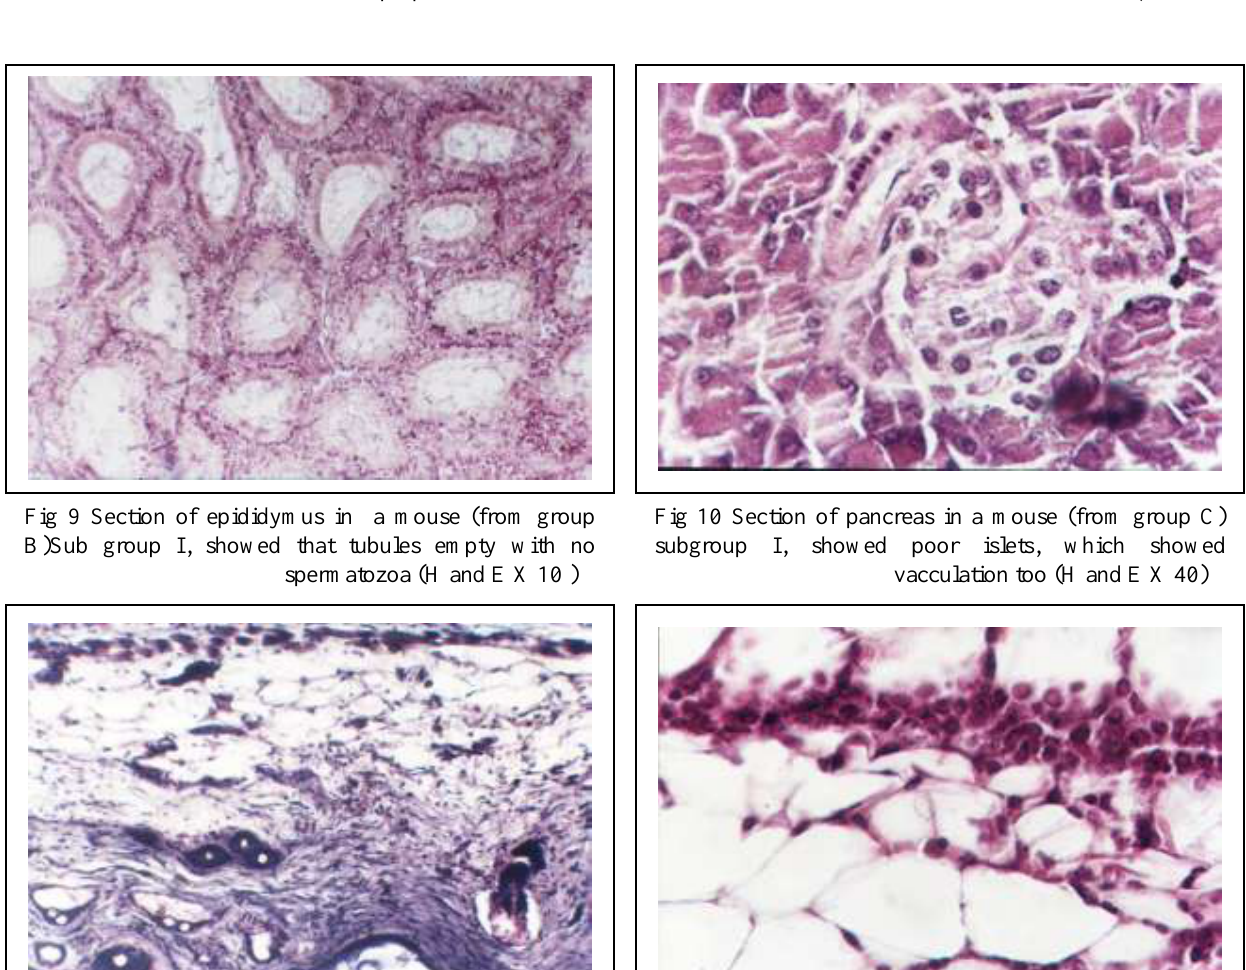
Fig(12)Section from visceral organ of adipose tissue in a mouse (from group C)sub group II , showed presence of foci of inflammatory cells ,indicate focal steatitis (H and